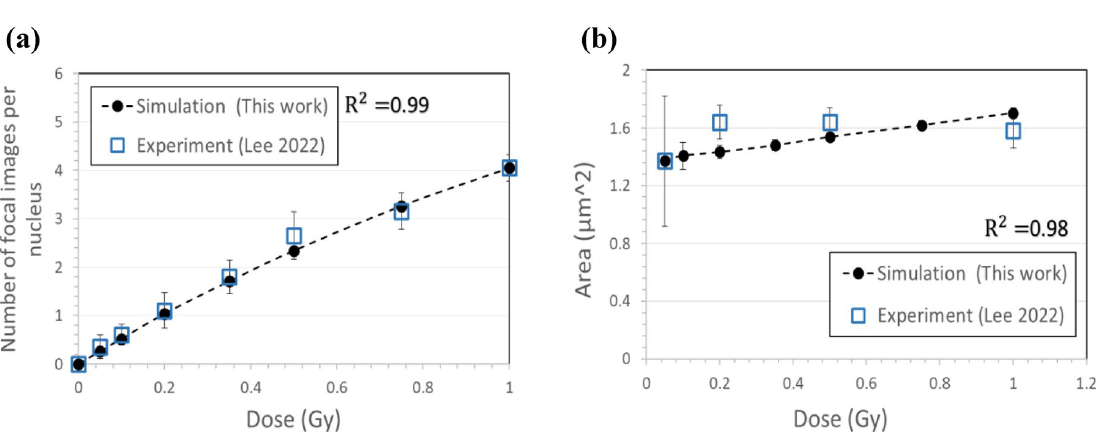
Figure 6. Estimates from Monte Carlo simulation compared with those from experimental measurement by Lee et al. 15 : ( a ) average number and ( b ) average area of γ-H2AX focal images in BEAS-2B cells 1 h after alpha particle